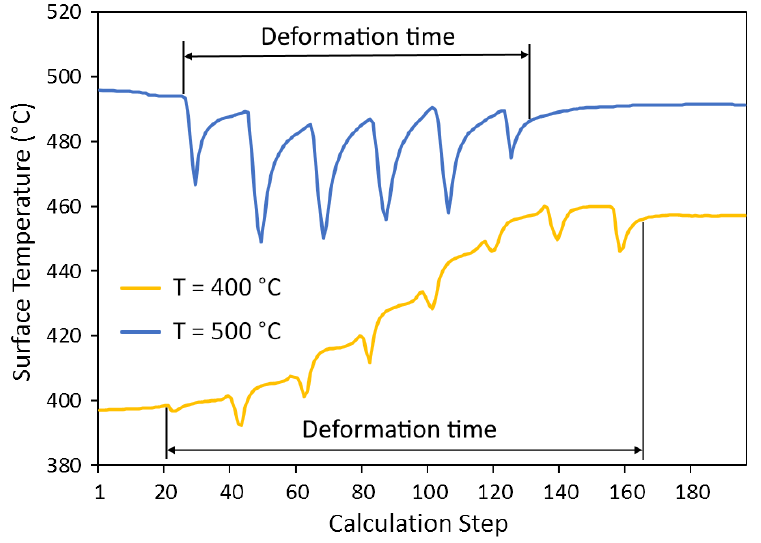
Figure 9. Change in temperature of point on bar surface along the deformation zone.